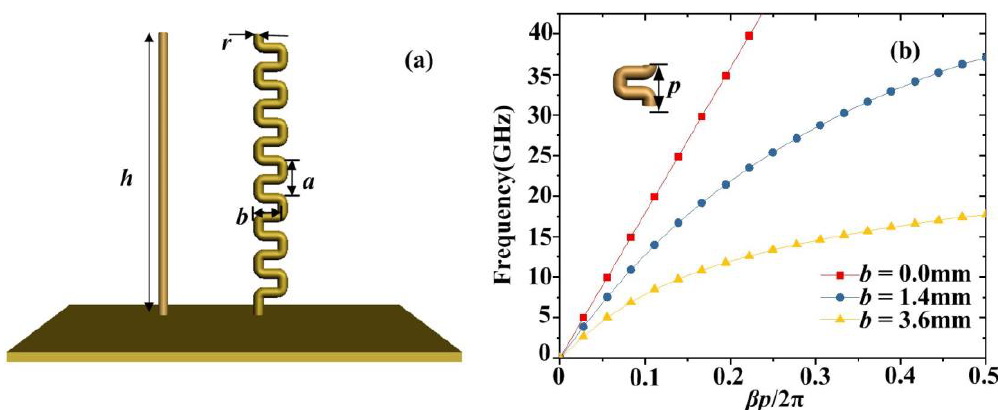
Figure 1. ( a ) The typical and plasmonic monopole antenna. The dimensions of the antennas: h = 25 mm, a = 0.65 mm, b = 1.4 mm, and r = 0.5 mm. ( b ) The dispersion relations of both antennas.